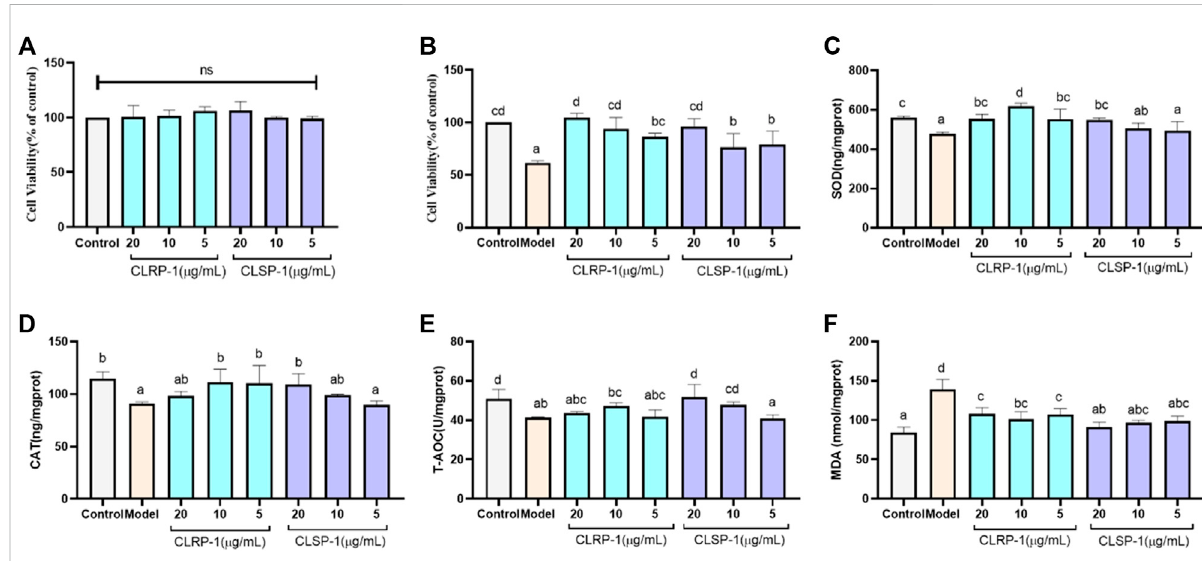
FIGURE 4 CLRP-1andCLSP-1promoteantioxidantdefenseofIPEC-J2cells. (A) CLRP-1andCLSP-1havenoproliferativetoxicitytonormalIPEC-J2cells. (B) The effectsofdifferentconcentrationsofCLRP-1 andCLSP-1treatedcells for12 h,then by400 μ MH 2 O 2 co-culture for12 hontheproliferation andviabilityofIPEC-J2 cells. (C) Quanti fi cationillustratesthelevel ofSOD. (D) Quanti fi cationillustratesthelevel ofCAT. (E) Quanti fi cation illustrates thelevel ofT-AOC. (F) Quanti fi cationillustratesthelevel ofMDA.Barswith differentlowercaseletters (a – d) aresigni fi cantly different( p <